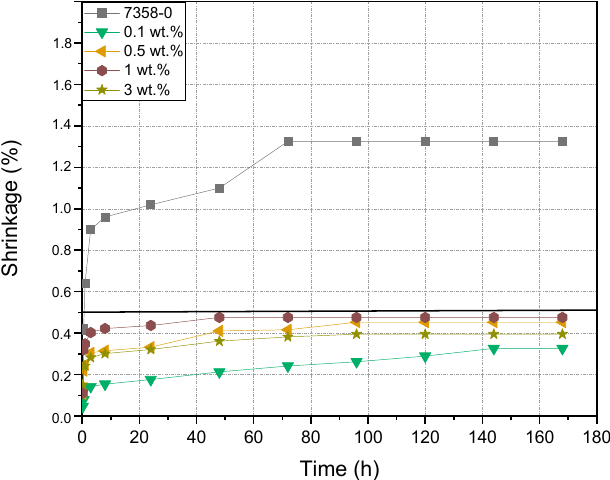
Figure 16. Influence of palygorskite-1.5MPTMS addition on shrinkage Si-PSA.